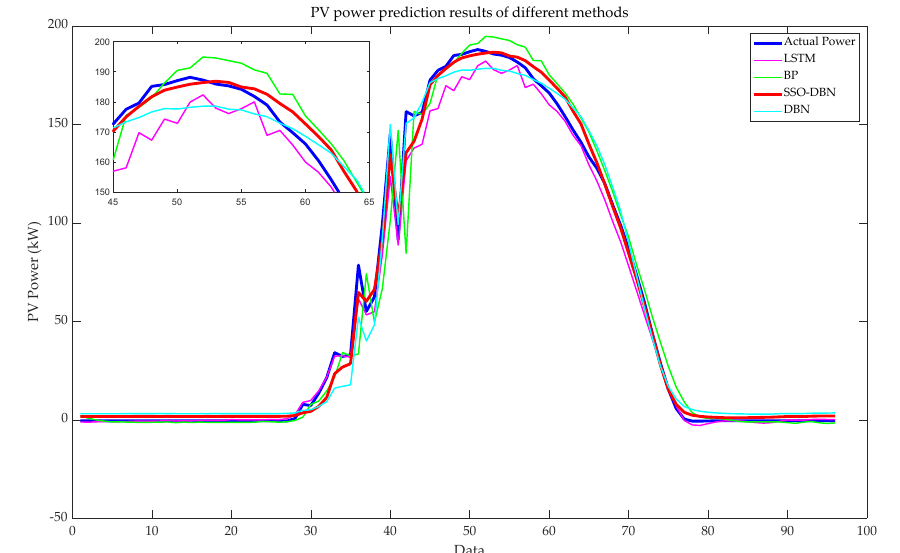
Figure 11. PV power prediction results under different inputs.